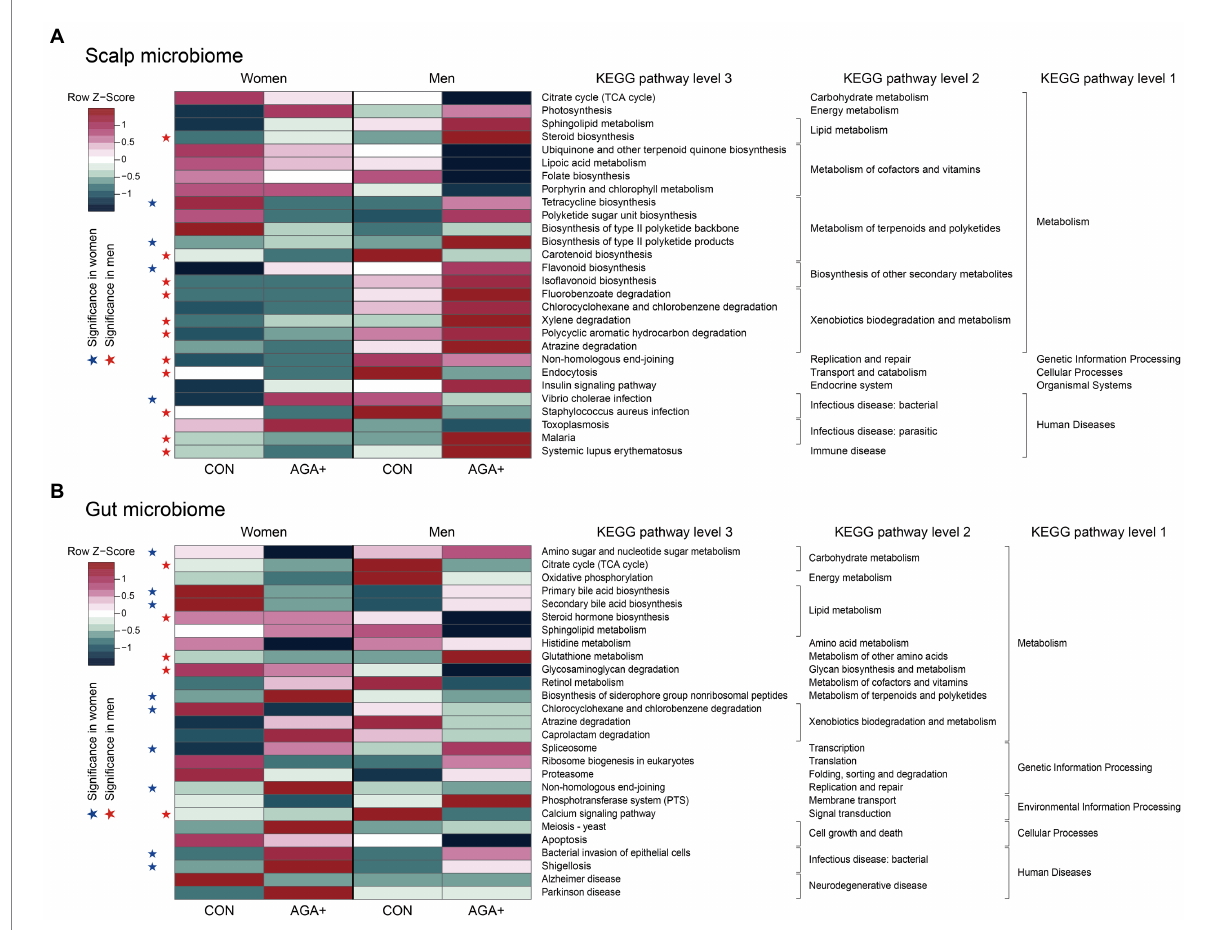
FIGURE 5 Heat map of differential bacterial functions predicted using PICRUSt2 in scalp (A) and gut (B) microbiome. The relative abundance of each microbiome was normalized based on row Z-scores. Blue (women) and red (men) stars indicate functions with significant differences between healthy controls (CON) and individuals with AGA